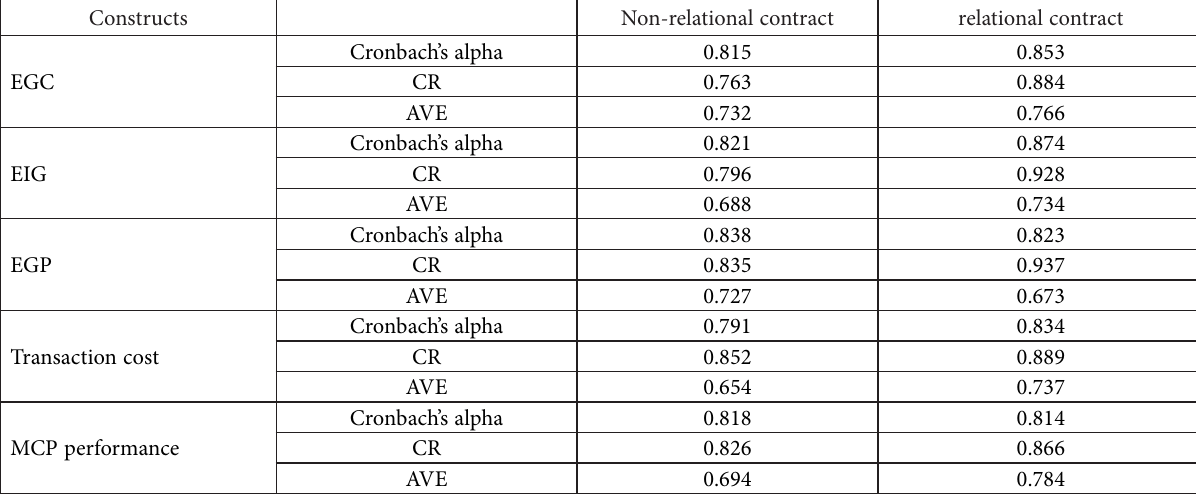
Table 3. Measurement reliability and convergent validity